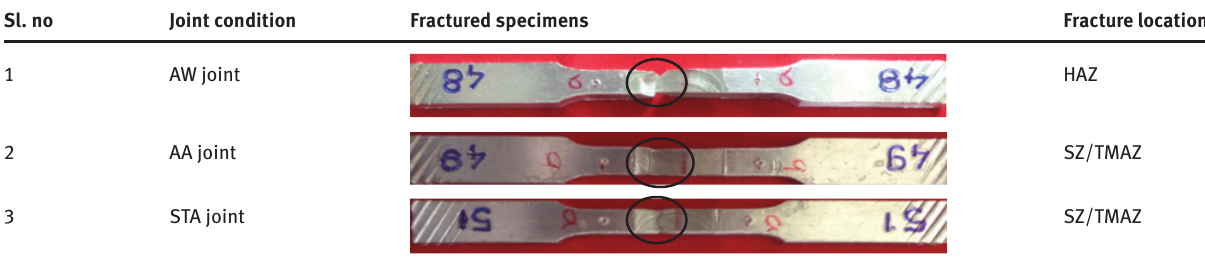
Table 5: Fracture location of FSW